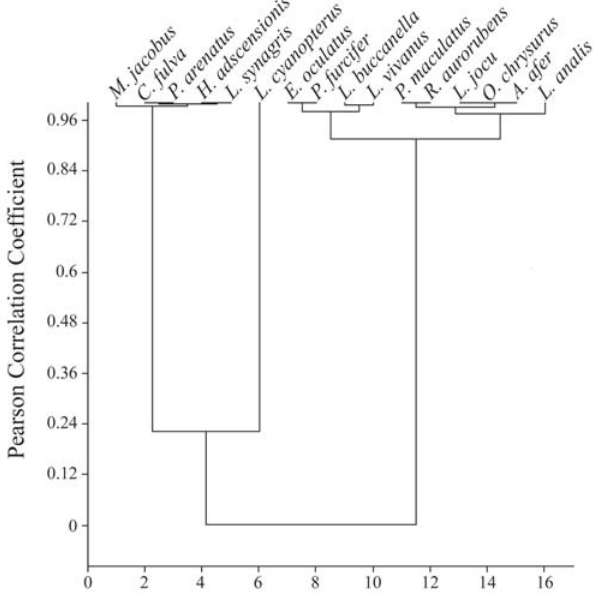
Fig. 3. Similarity dendrogram for the species of the snapper group according to the environments in which they are found, according to the perception of the fishermen from Ilhéus, Bahia State, Brazil (number of interviews = 15; for the E . oculatus and P . furcifer n = 7).